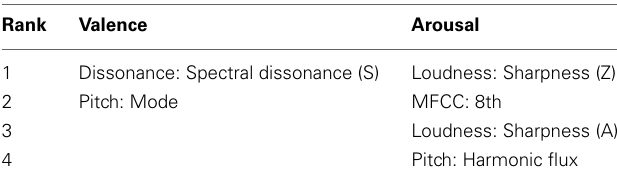
Table 4 | The informative musical features in the subject-independent multimodal